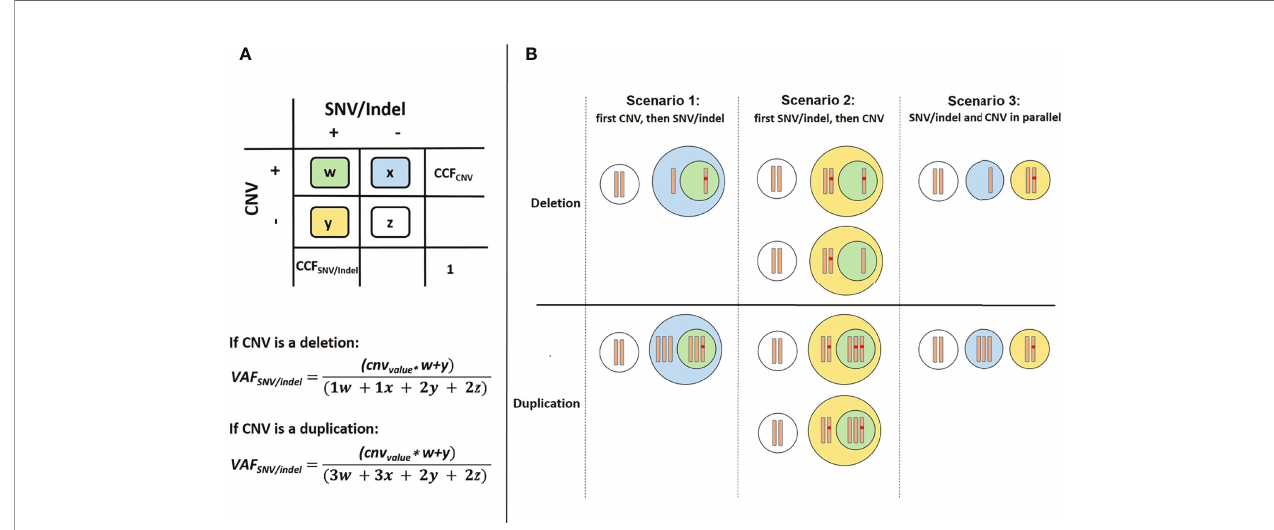
FIGURE 1 | Overview of cell types in case of a CNV overlapping the position of an SNV/indel. (A) Color scheme used for 4 possible cases. (B) Differentiation between the three possible